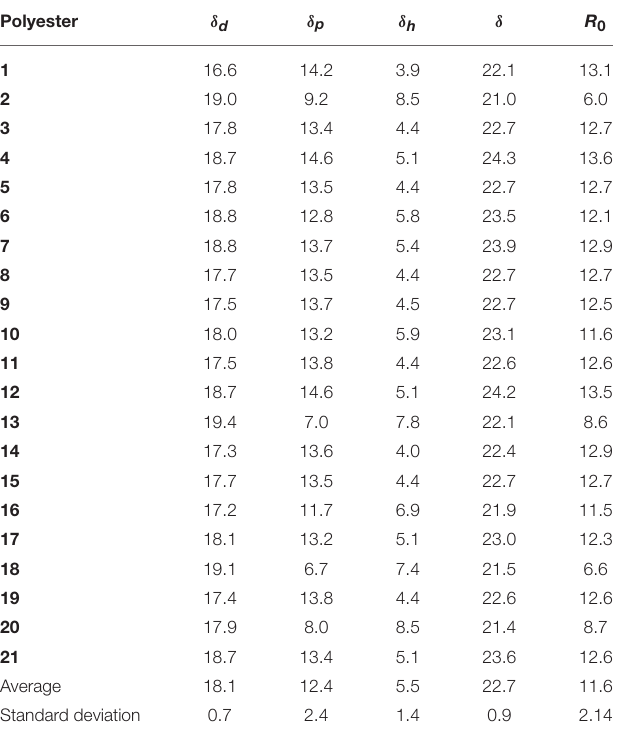
TABLE 2 | Hansen solubility parameter of the synthesized unsaturated polyesters.